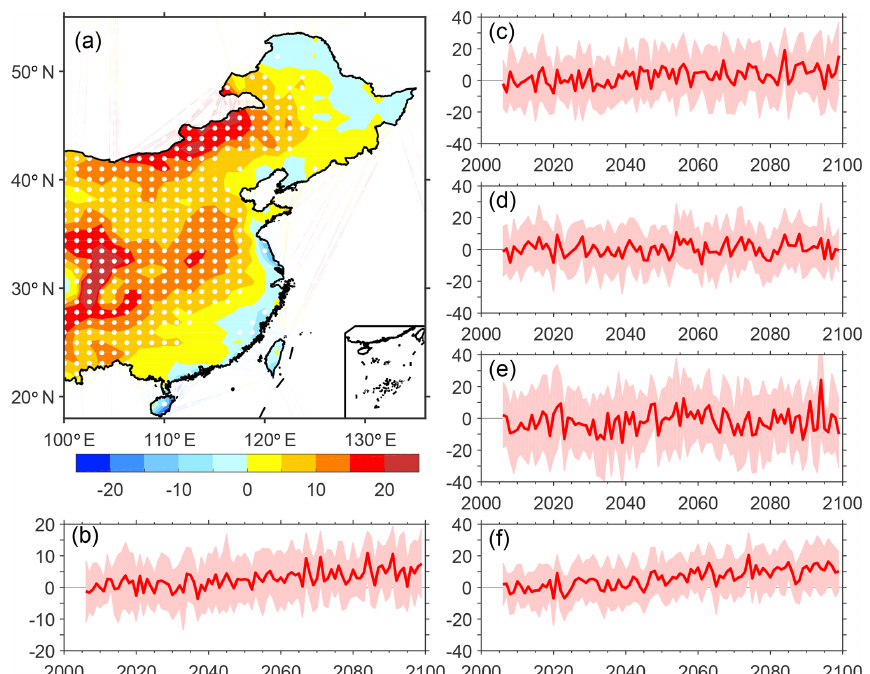
Figure 6. Changes in the stagnant conditions across China due to the GHG-induced warming. (a) Distribution of the relative changes in the stagnation days at the end of the 21st century against the current state (2006–2015). Dots mean the changes are significant at the 95% confidence level using Student t test for all years and ensembles. (b) Variations in the regional averaged stagnation days over eastern China. Ensemble variance (1 σ ) is shown in red shading. Panels (c) , (d) , (e) , and (f) are similar to (b) , but for the results of four Chinese economic zones, i.e. JJJ, YRD, PRD, and SCB. Units: percentage